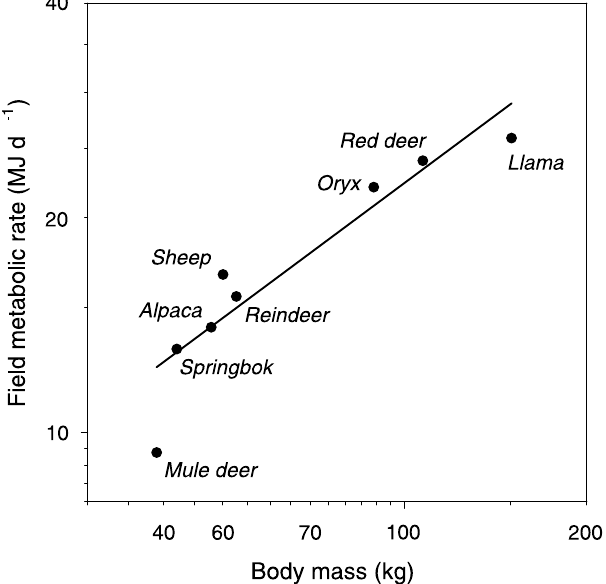
Figure 6. Relationship between daily energy expenditure and body mass in artiodactyls. Data are measurements of field metabolic rate (FMR) using the doubly labelled water method and body mass (BM) for eight artiodactyls (including data on llamas from the present study). The phylogenetically controlled allometric relationship is FMR (MJ d − 1 ) = 1.23 BM 0.63 ± 0.12 ( F 1,7 = 26.2, P < 0.001, R² = 0.81, ML λ = 0.64) (see text for